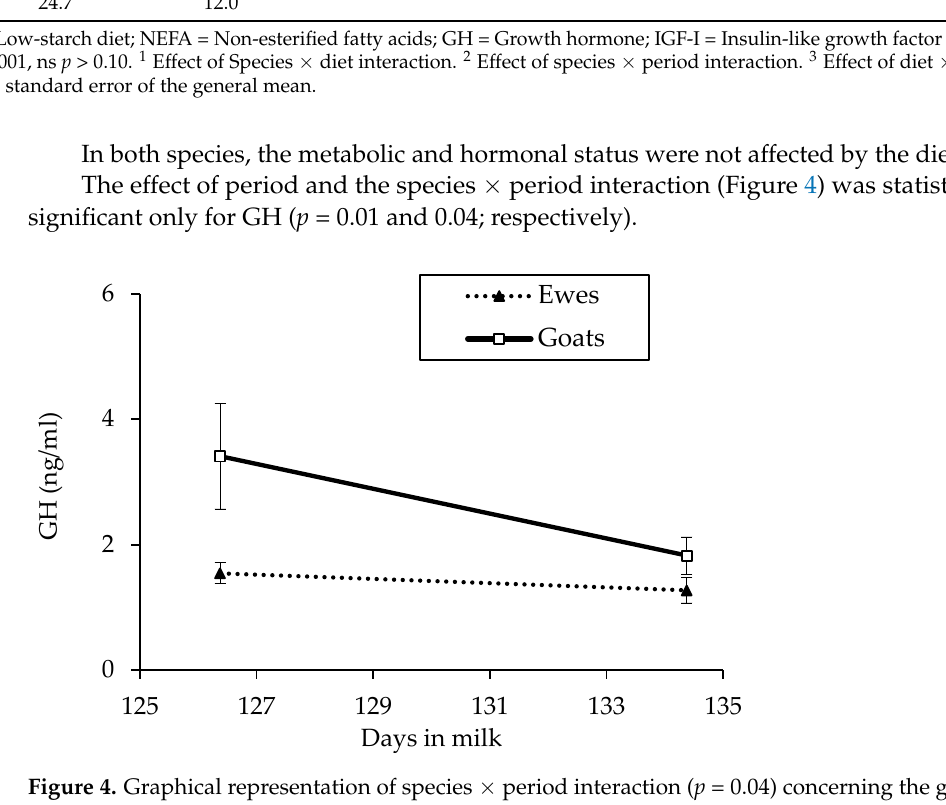
Table 5. Metabolic and hormonal profile (mean ± SEM) in plasma of mid-lactating Saanen goats and Sarda ewes fed high-starch and low-starch diets.